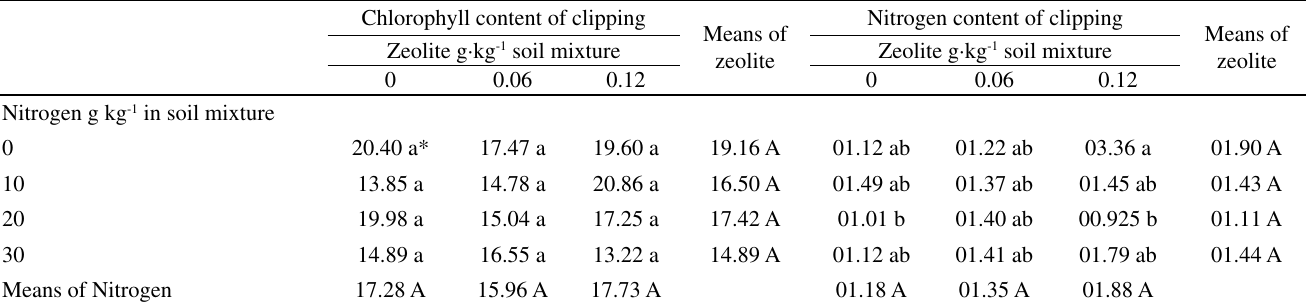
Table 3 - Effect of nitrogen and zeolite on chlorophyll and nitrogen content of clippings of Festuca arundinaceae Schreb ‘Starlet’ Chlorophyll content of clipping Means of